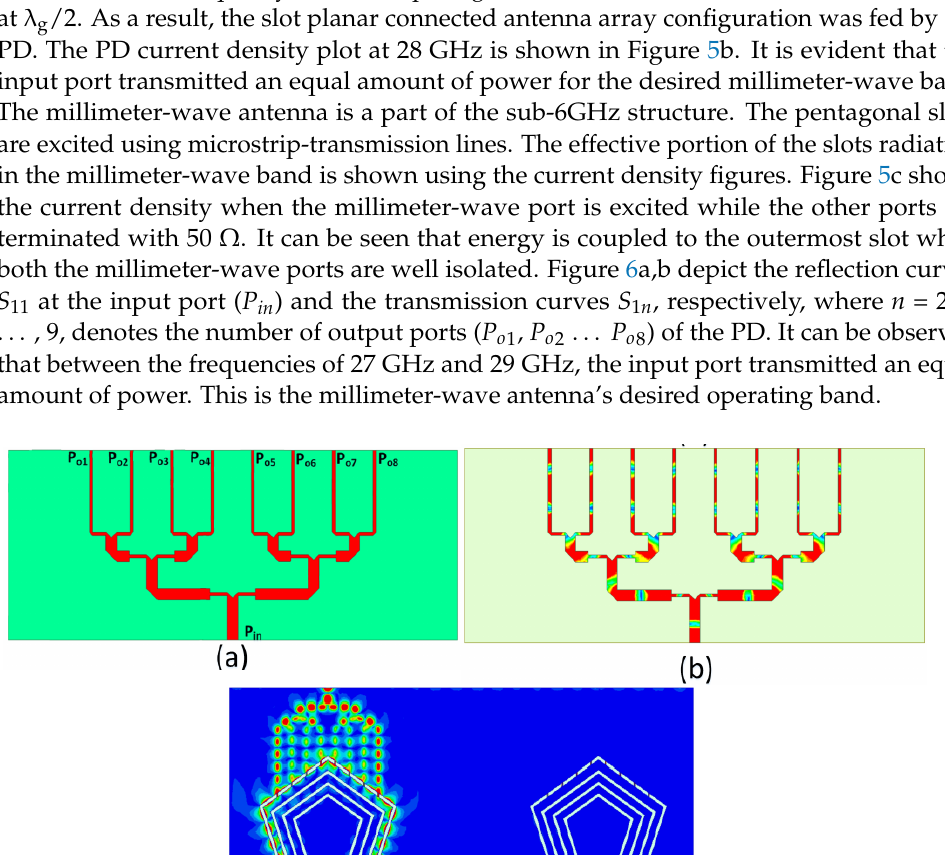
Figure 4. Effects of feed length: ( a ) Antenna with feeds ( b ) Optimal offset = 0 mm, Case-1: offset = 1 mm, Case-2: offset = 1 mm, Case-3: offset = 3 mm.